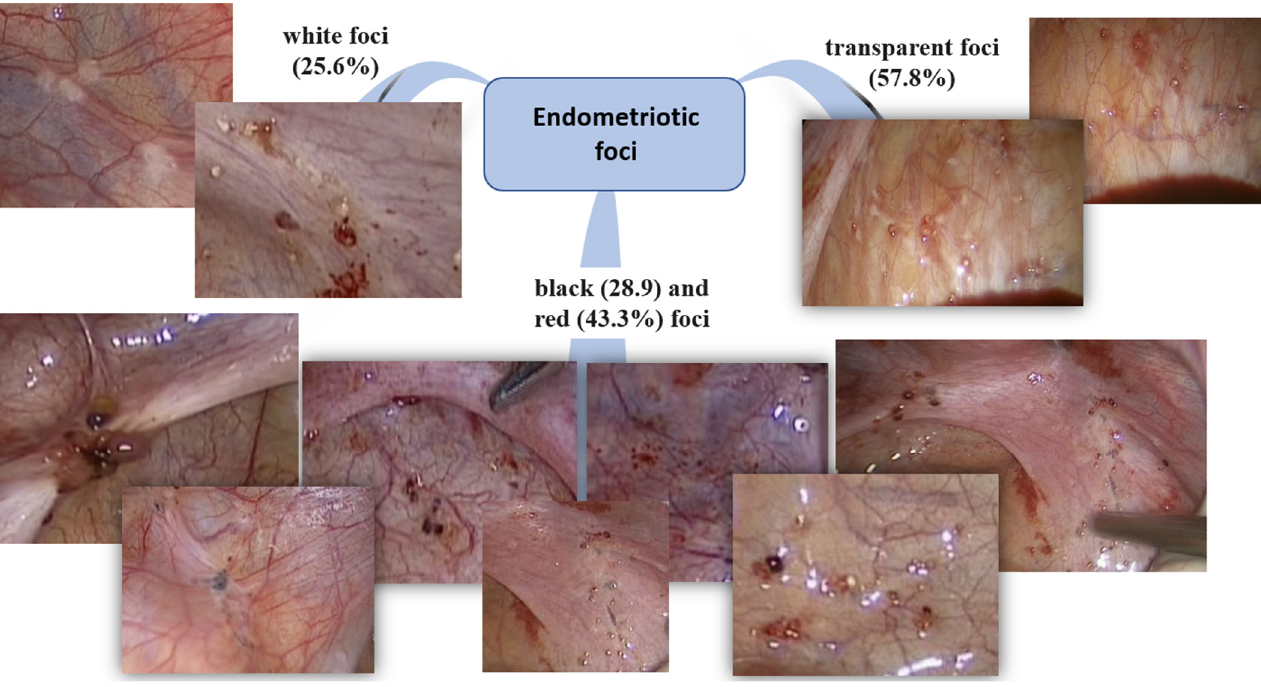
Figure 6. Characteristics and the color of endometriotic foci in adolescent patients in the study’s Table 4. Localization of endometriotic foci according to MRI and laparoscopy (LS) in the study’s sample.